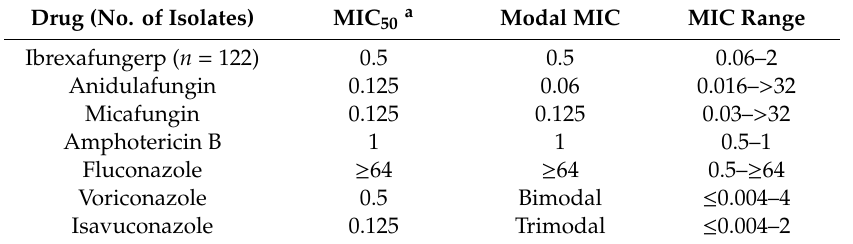
Table 1. In vitro activity of ibrexafungerp and comparators against C. auris isolates [33].